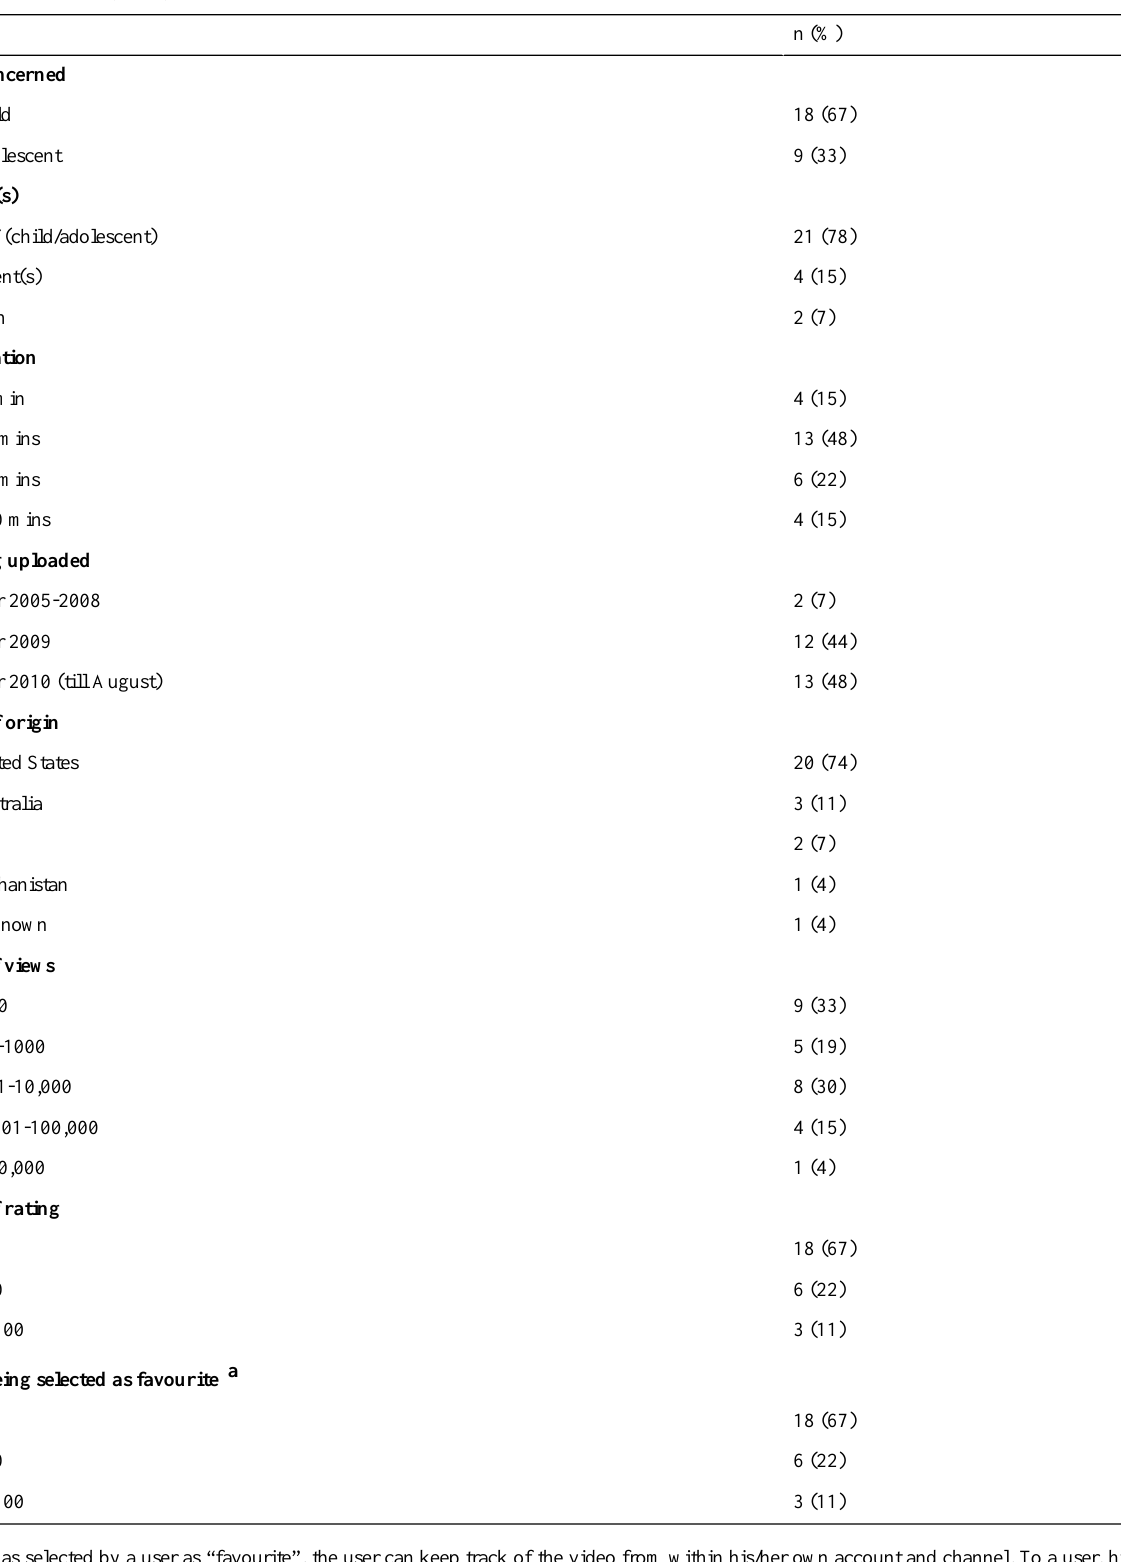
Table 1. Video statistics